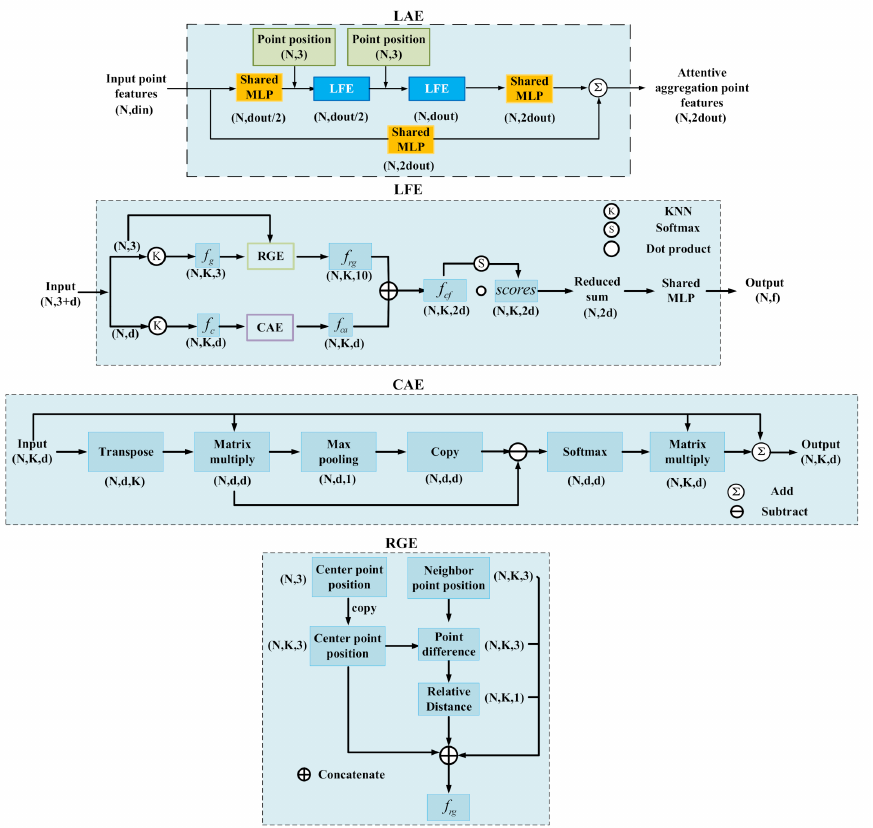
Figure 3. The LAE module and the LFE module. The CAE is our newly added module in the second branch of LFE. N is the number of input points, and K is the number of neighbor points of each point. The weight W was used to update F :